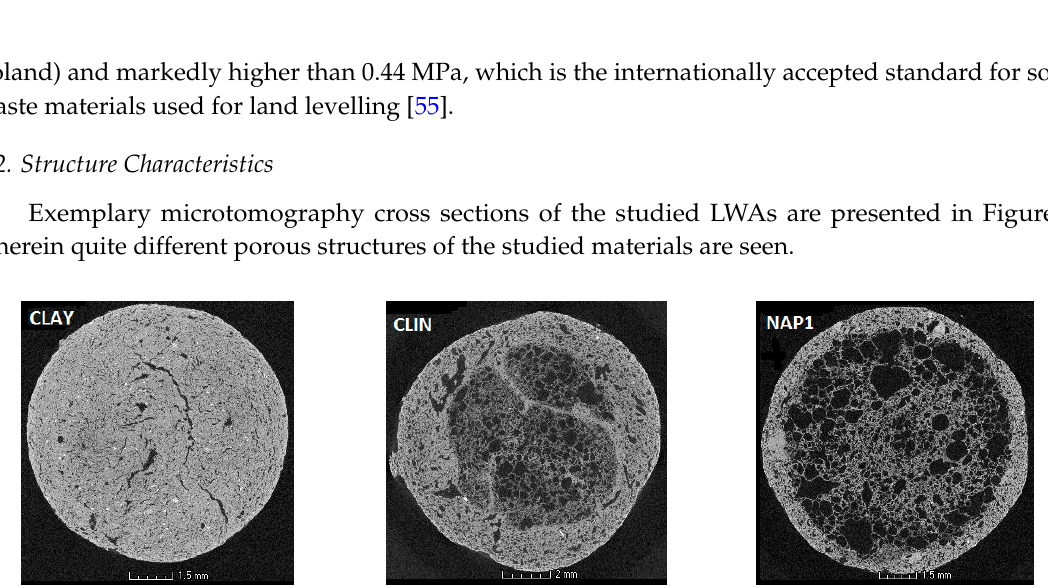
Figure 4. Exemplary 2D cross-sectional images derived from microtomography for the studied materials. Black areas: pores; white areas: solid.